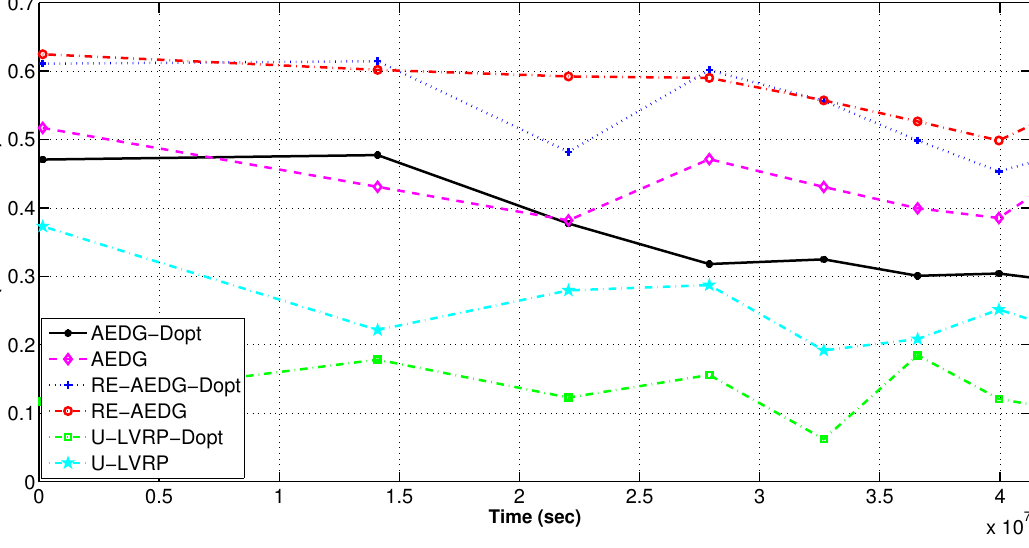
Figure 7. PAR in delay optimized and non optimized protocols.